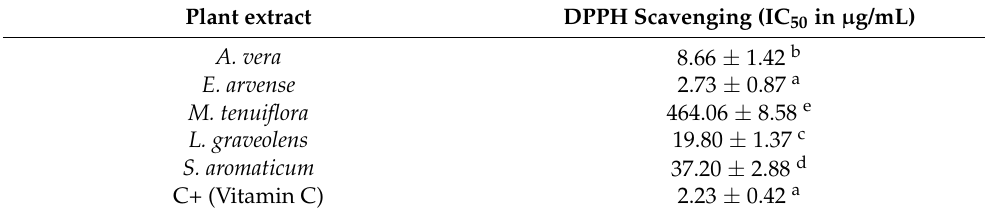
Table 5. Antioxidant activity.